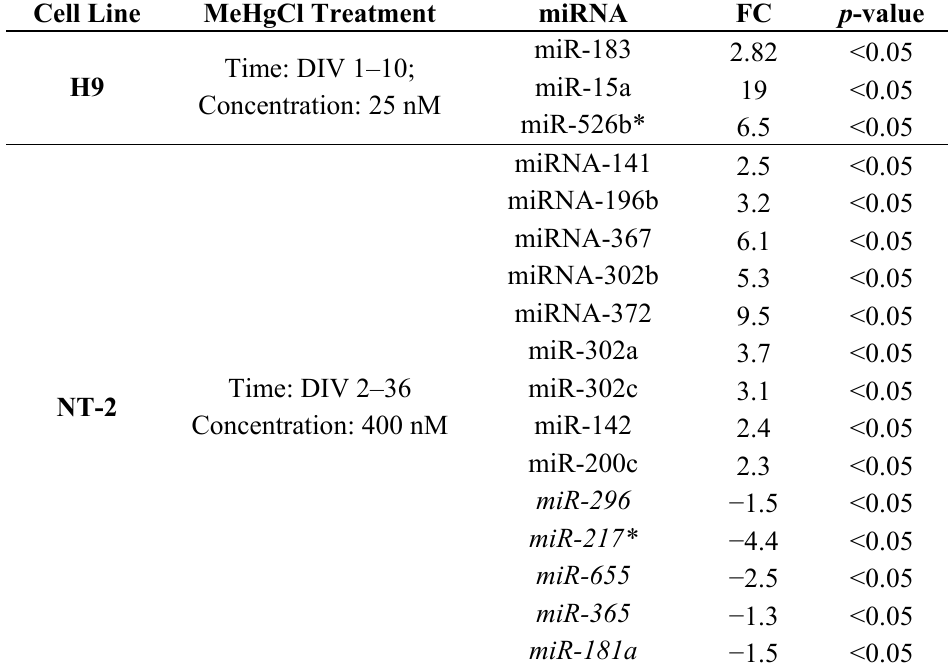
Table 1. List of miRNAs up- or down-regulated upon toxic treatment with methylmercury chloride (MeHgCl) in H9 and NT-2 cell lines. H9 cells were exposed to 25 nM MeHgCl during the first 10 days of differentiation. NT-2 cells were exposed to 400 nM MeHgCl from 2 to 36 DIV. The fold change (FC) of miRNA expression compared to respective untreated control is indicated for each miRNA (down-regulated miRNAs are reported in italic